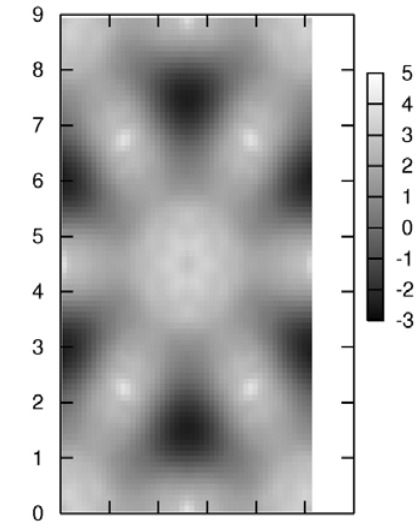
Fig. 4 – Effective potential ( k B T units) for the counterions in clays obtainedfrommoleculardynamicssimulations. Thedarkandthewhite part respectively correspond to the position of the Si and O atoms of the surface of the clay sheets. The length unit is Å. D IFFUSION OF I